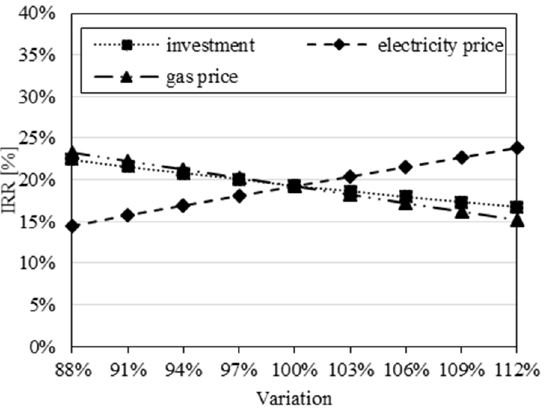
Figure 8. Sensitivity analysis of the project IRR by the standard economic method.